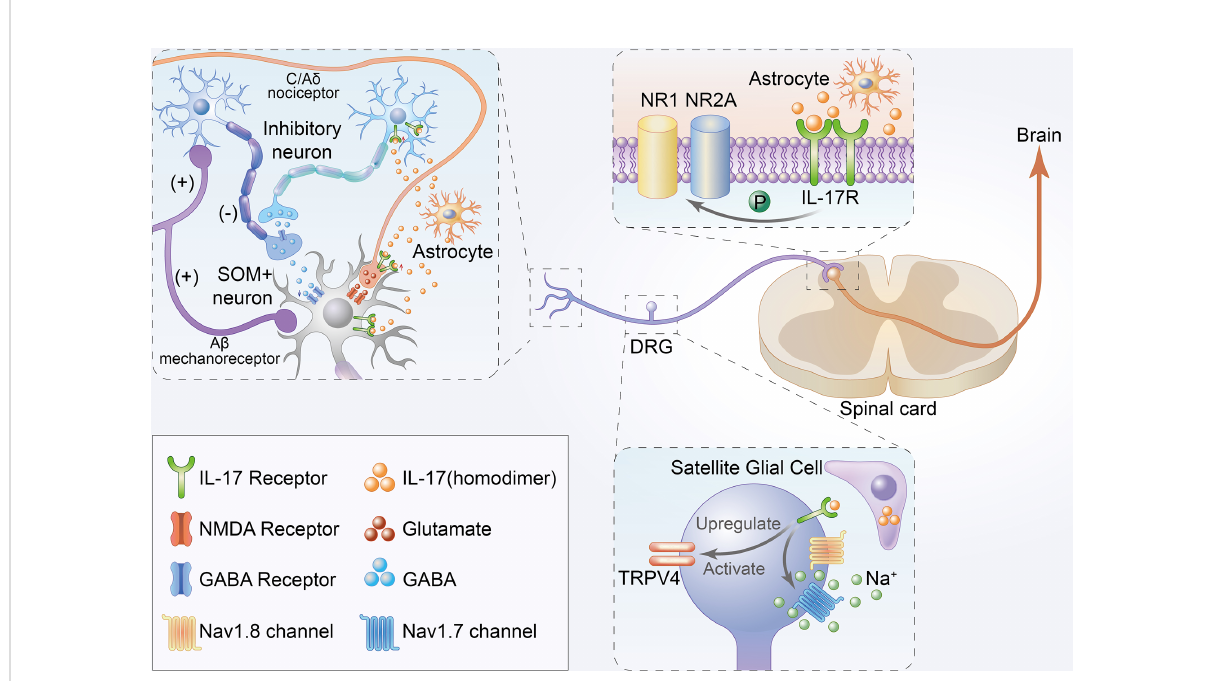
FIGURE 2 Schematic illustration of direct mechanisms of IL-17 in the development of chronic pain. Firstly, IL-17 produced by astrocytes not only enhances EPSCs but also suppresses inhibitory IPSCs and GABA-induced currents in the lamina II by interacting with neurons. Moreover, IL-17 from astrocytes can directly bind to IL-17Rs to mediate NAMD NR1 phosphorylation in the rat spinal cord. Thirdly, IL-17 from satellite glial cell can directly bind to IL-17R to upregulate and activate TRPV4 and increase tetrodotoxin-sensitive sodium currents in DRG